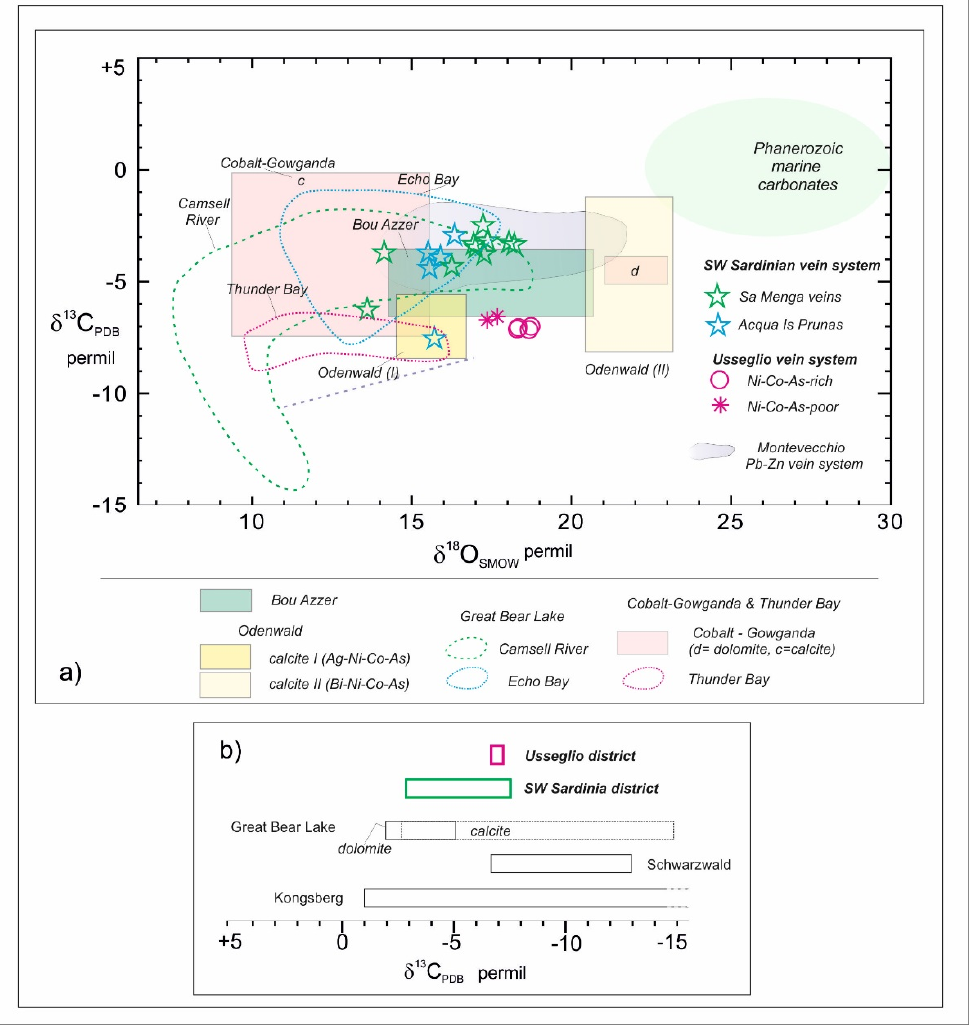
Figure 16. Stable isotope composition of ore-related carbonates. ( a ) Carbon and oxygen and ( b ) carbon-only isotopic composition of Fe carbonates from the SW Sardinian and Usseglio vein systems and comparison with isotopic data from the Montevecchio Zn–Pb vein system [30] and from several Co–Ni-rich, five element vein-type ore deposits world-wide [1,7,78–84]. Compositional field for Phanerozoic marine limestones after [78].